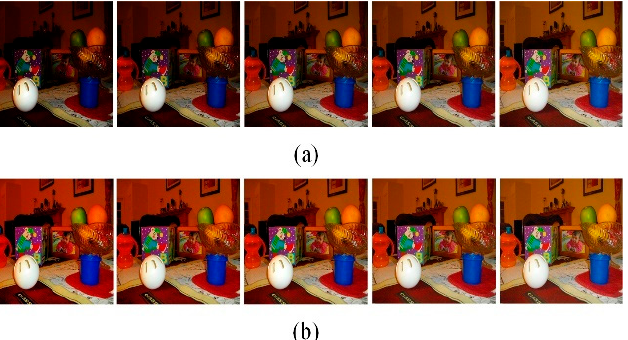
Figure 13. Office. ( a ) Input different global illumination image sequences. ( b ) Output almost the same global illumination image sequence.